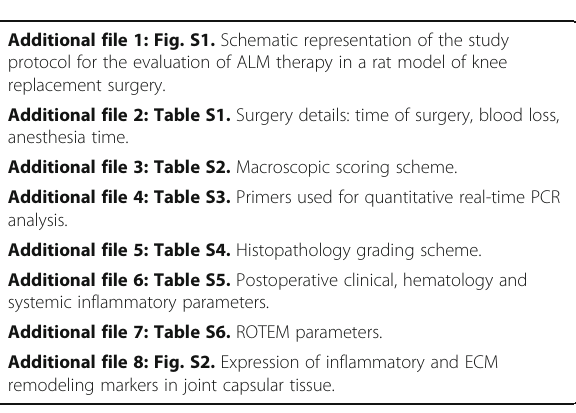
Additional file 3: Table S2. Macroscopic scoring scheme. Additional file 4: Table S3. Primers used for quantitative real-time PCR analysis. Additional file 5: Table S4. Histopathology grading scheme. Additional file 6: Table S5. Postoperative clinical, hematology and systemic inflammatory parameters. Additional file 7: Table S6. ROTEM